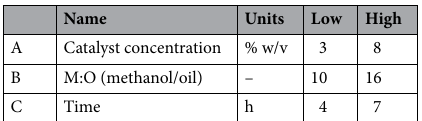
Table 1. Codes and ranges of three independent variables in RSM design.